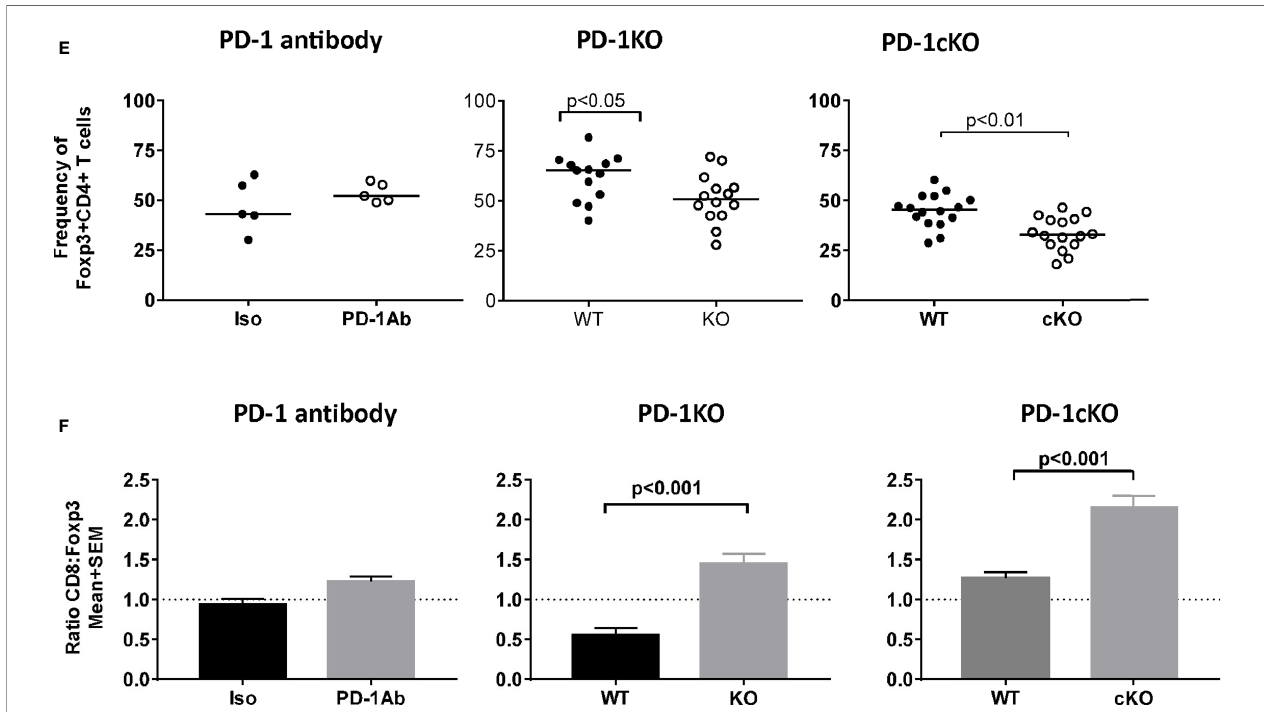
FIGURE 2 | Absence of PD-1 signaling leads to an increase in frequency CD8 + ICOS + TILs and a reduction in CD4 + FoxP3 + Tregs. Tumors were excised and weighed and tumor-in fi ltrating lymphocytes were isolated from PD-1 Ab-treated (day 15 post-tumor implant), PD-1KO (day 11 post-tumor implant), and PD-1cKO (day 22 post-tumor implant) mice and multiparameter fl ow cytometry analysis performed. (A) Frequency of CD45 + leukocytes of live and frequency of CD3 + T cells of tumor-in fi ltrating lymphocytes in PD-1 Ab-treated, PD-1KO, and PD-1cKO mice and their respective controls. (B) Weight of tumor in grams and number of cells normalized by tumor size isolated from the tumor of PD-1 Ab-treated, PD-1KO, and PD-1cKO mice and respective control mice. (C) Ratio of the frequency of CD8 and CD4 TILs. (D) Frequency of Ki67 + and ICOS+CD8 + TILs. (E) Frequency of Foxp3 + T cells among the CD4 + TILs. (F) Ratio of CD8 + to Foxp3 + T cells in the tumor tissue. Data representative of three independent experiments with n = 4 – 5 mice/experiment, group, and time point. See also Supplementary Figure S2